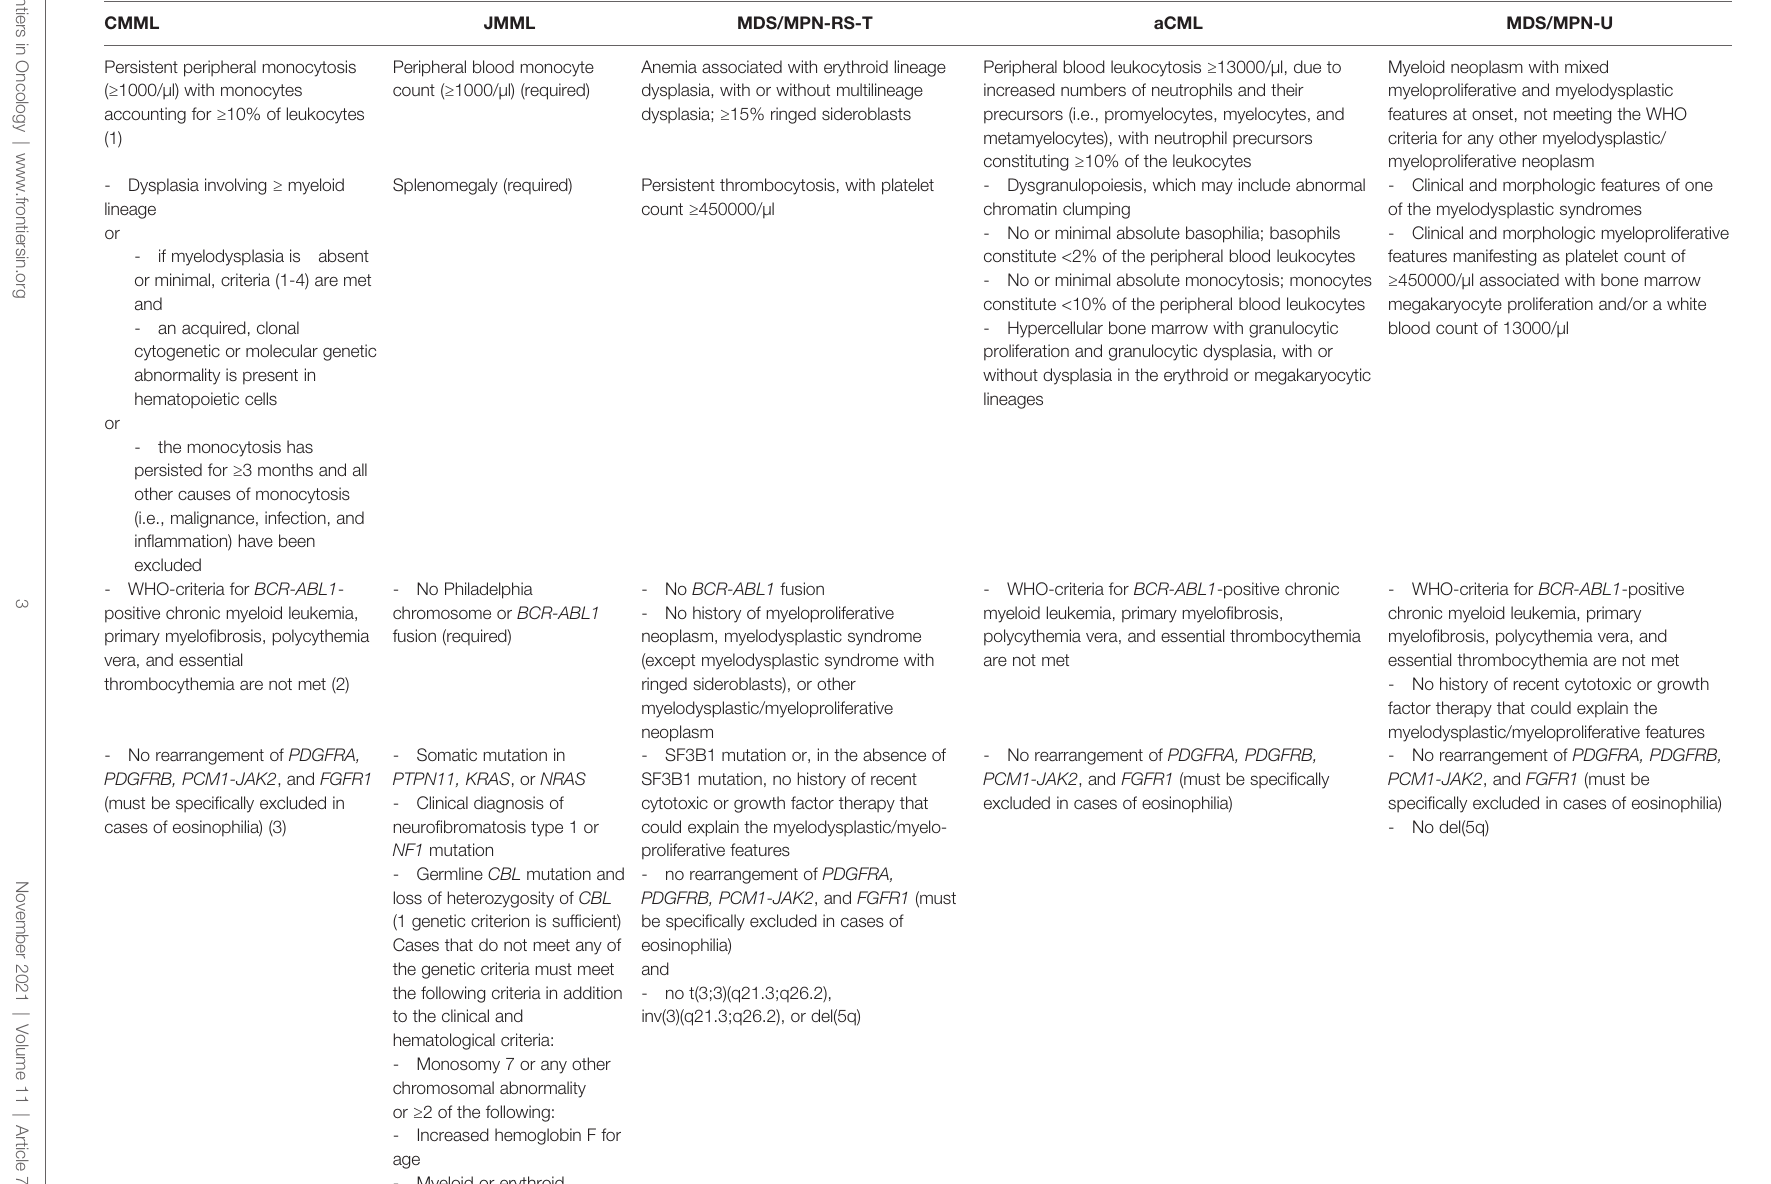
TABLE 1 | Main diagnostic criteria of the MDS/MPN subgroups according to WHO 2016 (1). CMML Persistent peripheral monocytosis ( ≥ 1000/µl) with